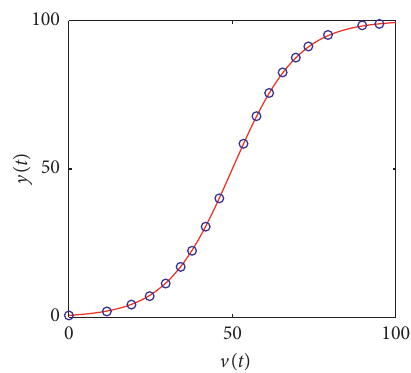
Figure 12: Numerical example 1: comparison between real non- linear function tansig (red) and captured nonlinearity (blue